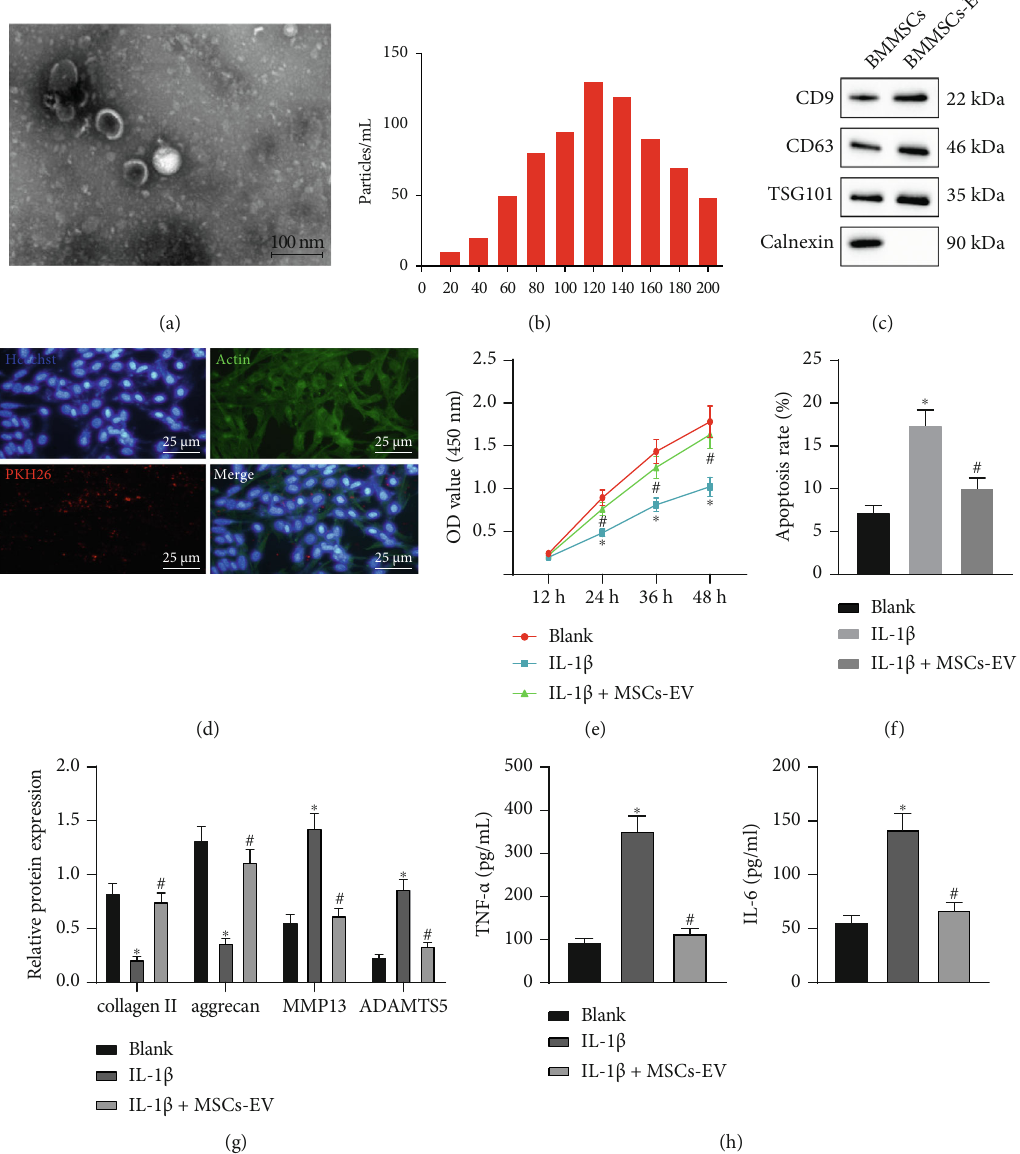
Figure 1: MSCs-EVs suppresses IL-1 β -induced chondrocyte in fl ammation and ECM degradation in OA. (a) The morphology of EVs observed under the TEM ( scalebar = 100nm ). (b) The distribution of EVs analyzed by NTA. (c) Protein levels of CD9, CD63, TSG101, and Calnexin measured by immunoblotting. (d) The uptake of EVs by chondrocytes observed under the microscope ( scalebar = 25 μ m ). Chondrocytes were treated with IL-1 β and/or MSCs-EVs. (e) Cell proliferation assessed by CCK8 assay. (f) Apoptosis assessed by fl ow cytometry. (g) Protein levels of collagen II, aggrecan, MMP13, and ADAMTS5 in chondrocytes measured by immunoblotting. (h) Levels of IL-6 and TNF- α in chondrocytes measured by ELISA. ∗ p < 0 : 05 vs. BMMSCs or chondrocytes without treatment, # p < 0 : 05 vs. chondrocytes treated with IL-1 β . Data are shown as the mean ± standard deviation of three technical replicates. Data between two groups were compared by independent t -test. Data comparisons among multiple groups were analyzed by the one-way ANOVA with Tukey ’ s post hoc test, and comparison of data at di ff erent time points was analyzed using repeated measurement ANOVA with Tukey ’ s post hoc